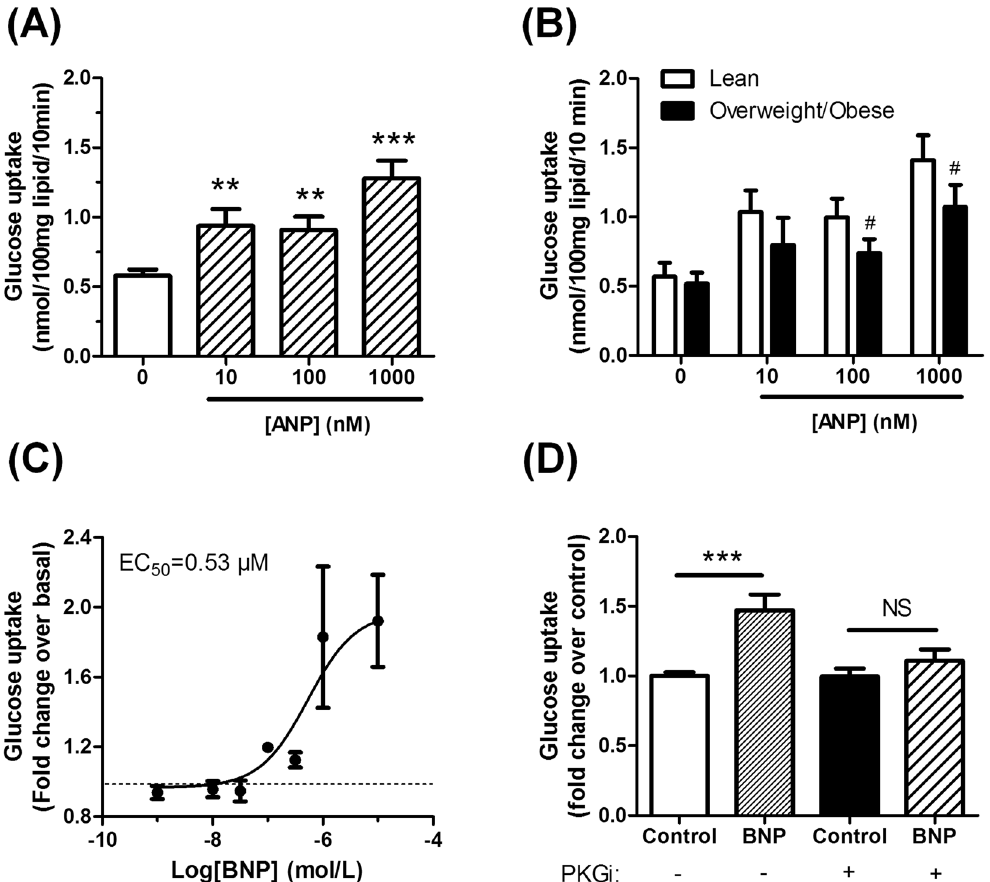
Figure 3. Natriuretic peptides promote glucose uptake in a cGMP-dependent manner in human adipocytes. ( A ) Dose-response effect of ANP on 2-deoxyglucose uptake in human isolated adipocytes (n = 13). ( B ) Dose- response effect of ANP on 2-deoxyglucose uptake in human isolated adipocytes from lean (n = 14) versus overweight/obese subjects (n = 9). # p = 0.06 vs. lean. ( C ) Dose-response effect of BNP on 2-deoxyglucose uptake in differentiated hMADS adipocytes (n = 8). ( D ) BNP (100 nM)-mediated glucose uptake in absence or presence of (Rp)-8-pCPT-cGMPS 100 µ M (PKG inhibitor, PKGi) in differentiated hMADS adipocytes (n = 8). * p < 0.05, ** p < 0.01, *** p < 0.0001 vs. 0 or